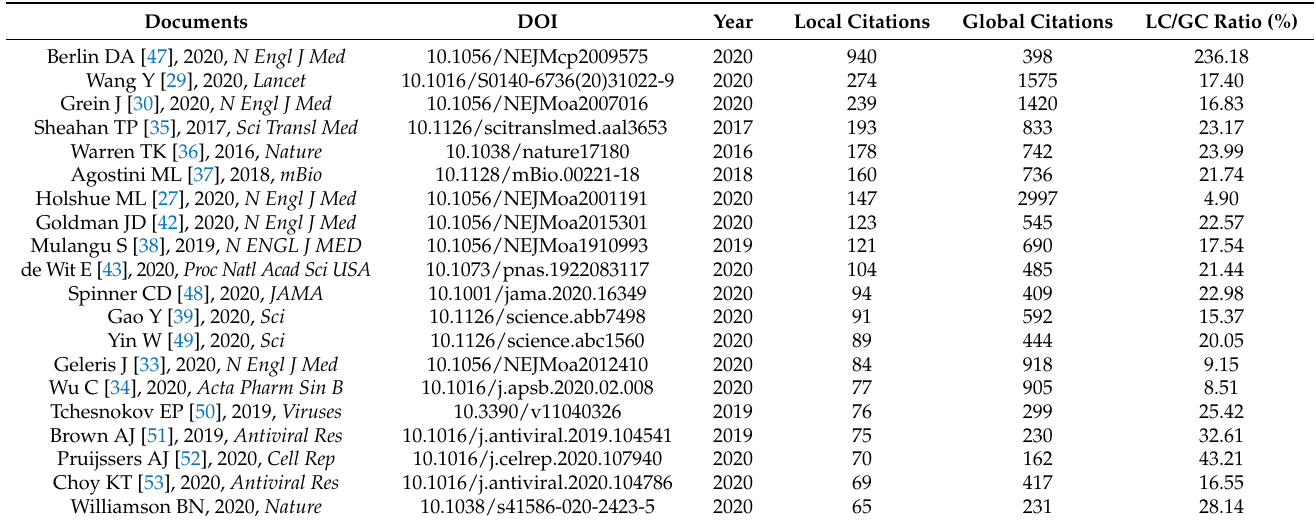
Table 4. Top 20 most frequently locally cited documents.